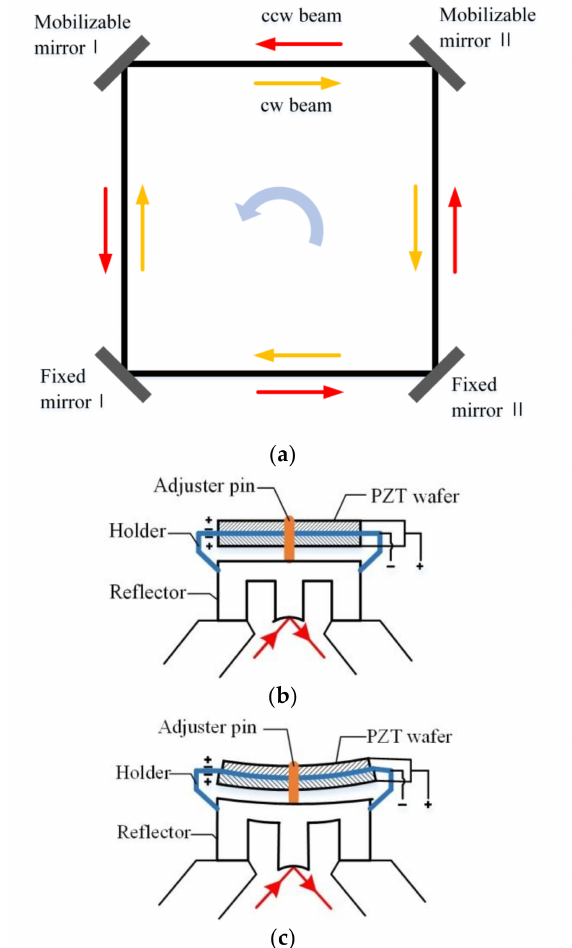
Figure 1. The basic setup of a square ring laser gyro. ( a ) Overall perspective of square ring laser gyro. ( b ) Detail of mobilizable mirror. ( c ) Adjustment principle.